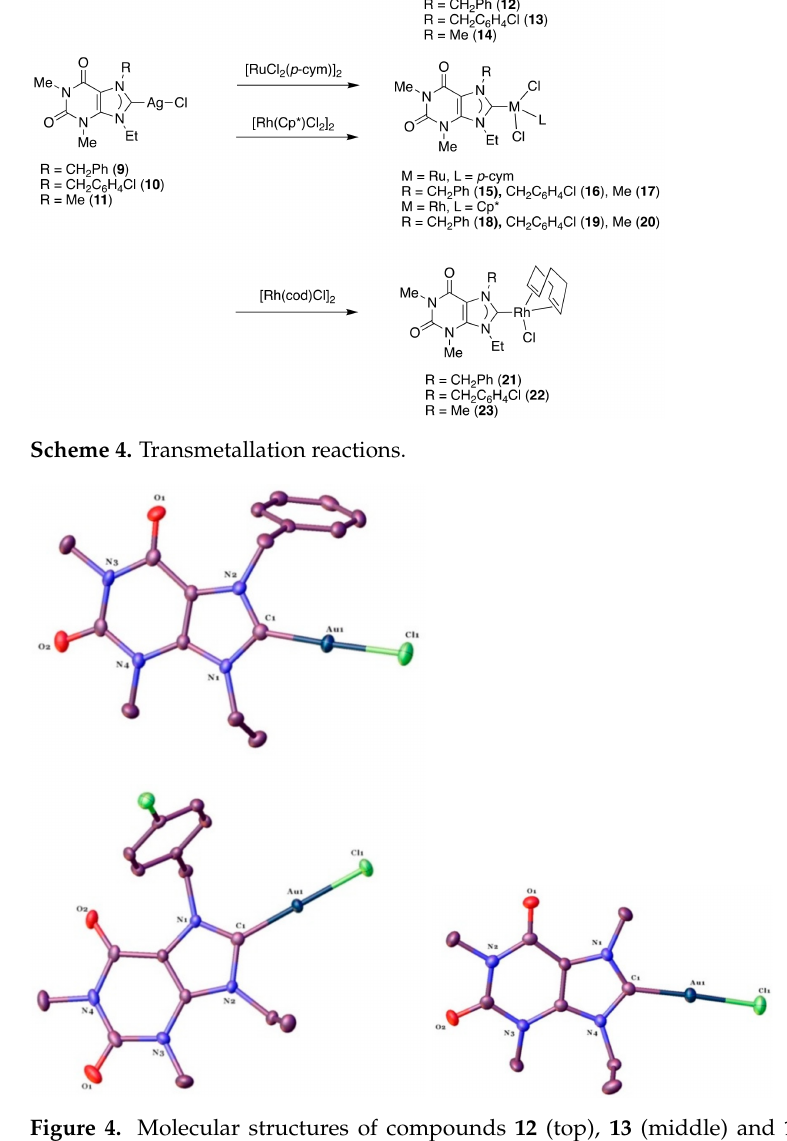
Figure 4. Molecular structures of compounds 12 (top), 13 (middle) and 14 (bottom). Thermal ellipsoids are drawn at the 50% level. Hydrogen atoms have been omitted for clarity.